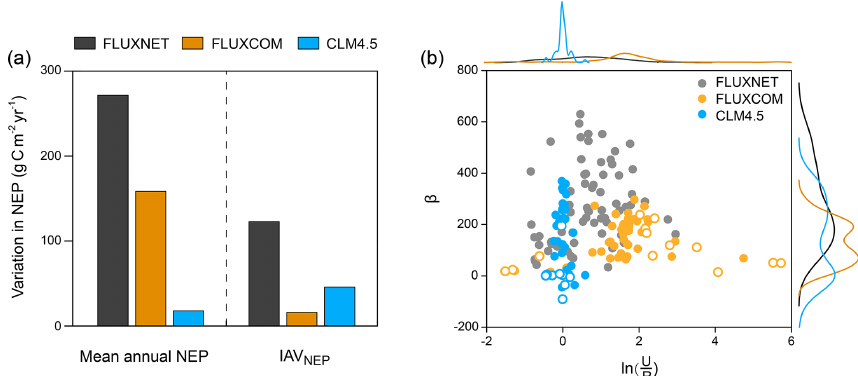
Figure 5. Representations of the spatially varying NEP and its local indicators in the FLUXCOM product and the Community Land Model (CLM4.5) at the FLUXNET site level. (a) The variation in mean annual NEP and IAV NEP is derived from FLUXNET, FLUXCOM and CLM4.5. Variation in mean annual NEP: the standard deviation of mean annual NEP across sites; variation in IAV NEP : the standard deviation of IAV NEP across sites. (b) Representations of the local indicators for NEP in FLUXNET, FLUXCOM and CLM4.5. The corresponding ) and β are shown at the top and right. Significance of the relationship between annual NEP and ln ( U distributions of ln ( U R indicated by the circles. Closed circles: P < 0 . 05; open circles: P > 0 . 05. Note that the modelled results are from the pixels extracted from the same locations of the flux tower sites.